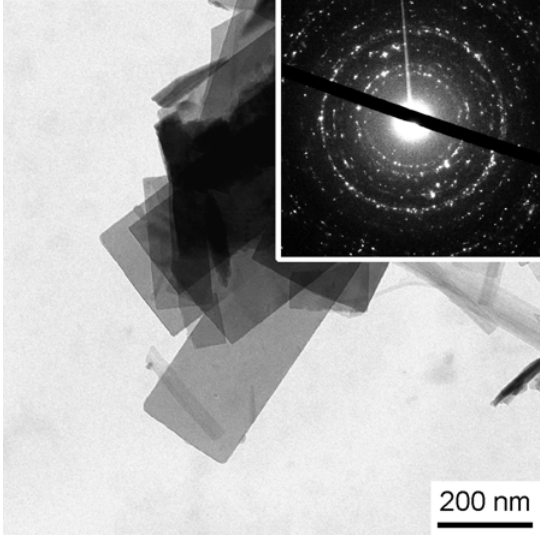
Figure 5 . TEM image and electron diffraction pattern of platelets obtained after 30 hours of reaction